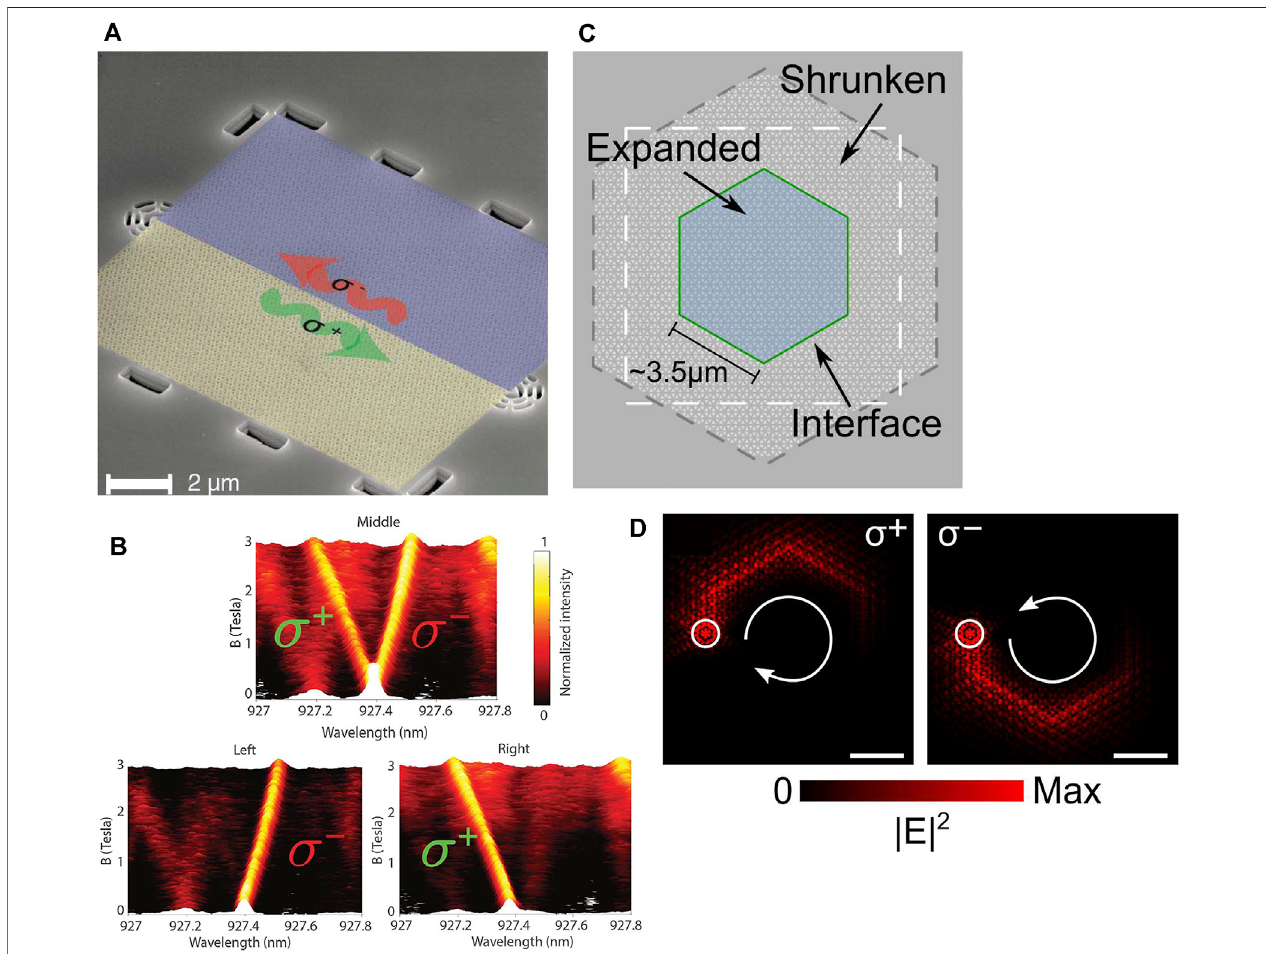
FIGURE 2 | (A) Schematic of the chiral quantum interface formed by connecting two photonic crystal structures with different band topologies indicated by blue andyellow[83]. (B) Emissionandtransmissionspectrumcollectedfromthepositionofaquantumdot,leftandrightgratingoutputcouplersasafunctionofthemagnetic fi eld, respectively. (C) Schematic of the ring resonator constituted by embedding a topological nontrivial region of hexagonal shape with expanded honeycomb lattice (blue area) in the center of the topological trivial region with shrunk honeycomb lattice (grey area). The green solid line indicates the interface between two topologically distinct photonic crystal regions [72]. (D) The electric fi eld intensity distribution of two pseudo spin edge modes with opposite polarization excited by inversely polarized dipole sources represented by the white open circle.